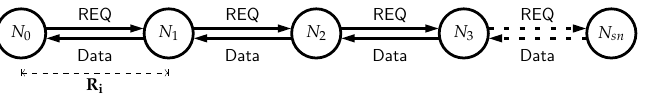
Figure 4. FD-based linear UASN network